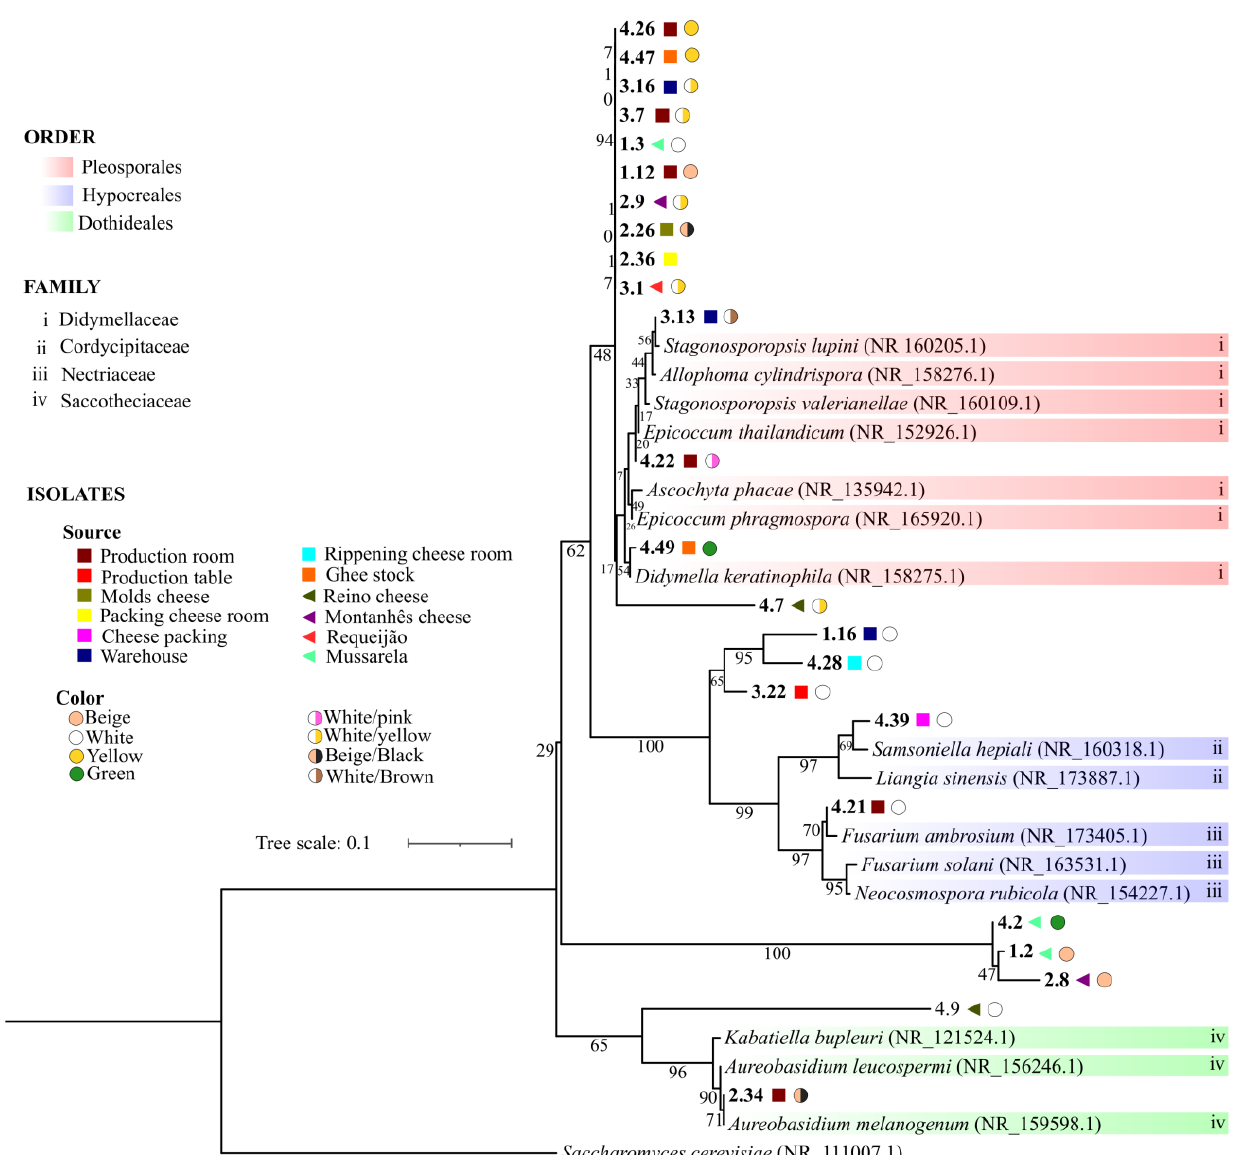
Figure 3. Phylogenetic analysis of not identified isolates.